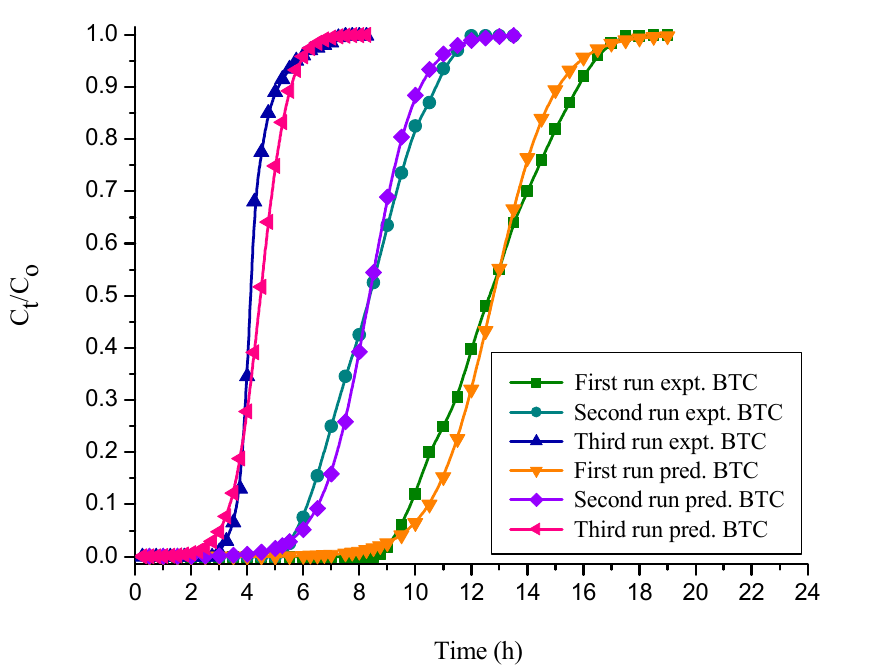
Figure 8. BTCs for experimental vs. simulated Yoon–Nelson model for the decolorization of CR by free NNLP adsorbent in various runs. (Initial pH: 6; flow rate: 1 mL min − 1 ; inlet dye concentration: 15 mg L − 1 ; temperature: 301 K)